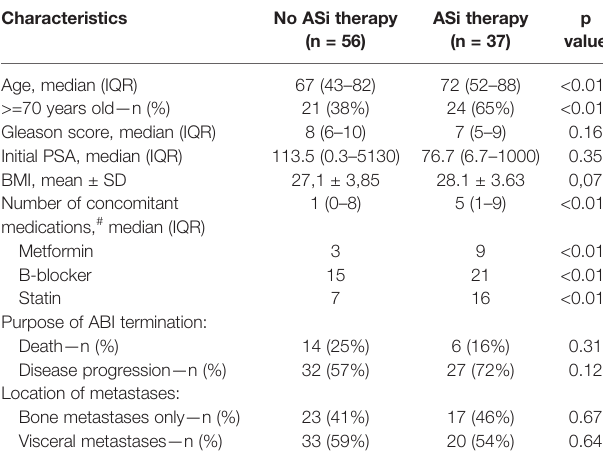
TABLE 4 | The comparison of the patients with or without ASi therapy.